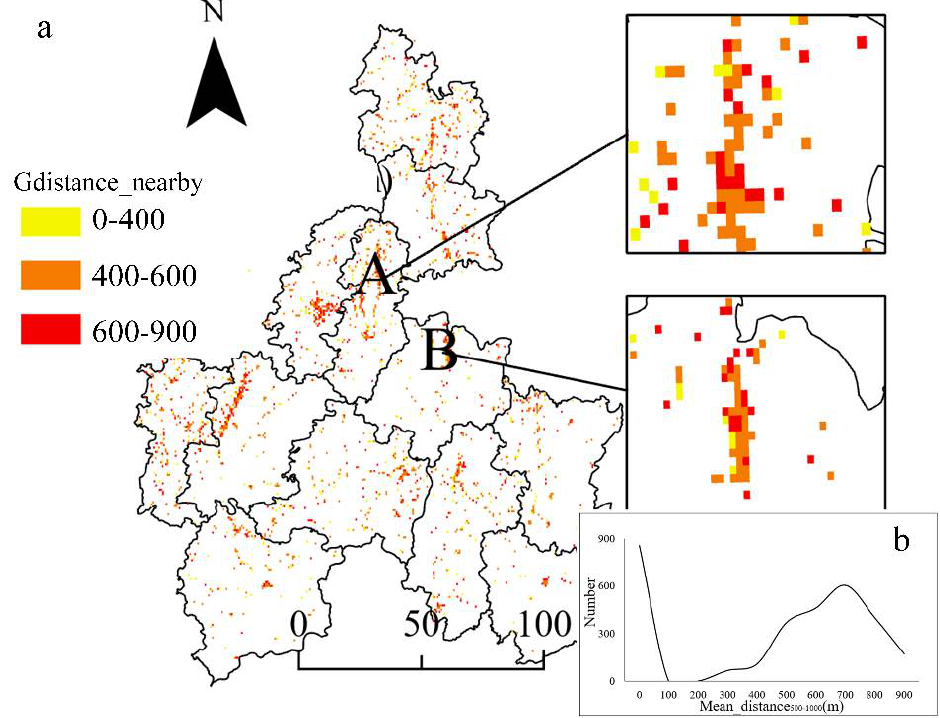
Figure 11. ( a ) Distribution of the nearby grids distance-based competition index. ( b ) Relationship curve of nearby grids distance-based competition index and the number of shops in the grid scale.